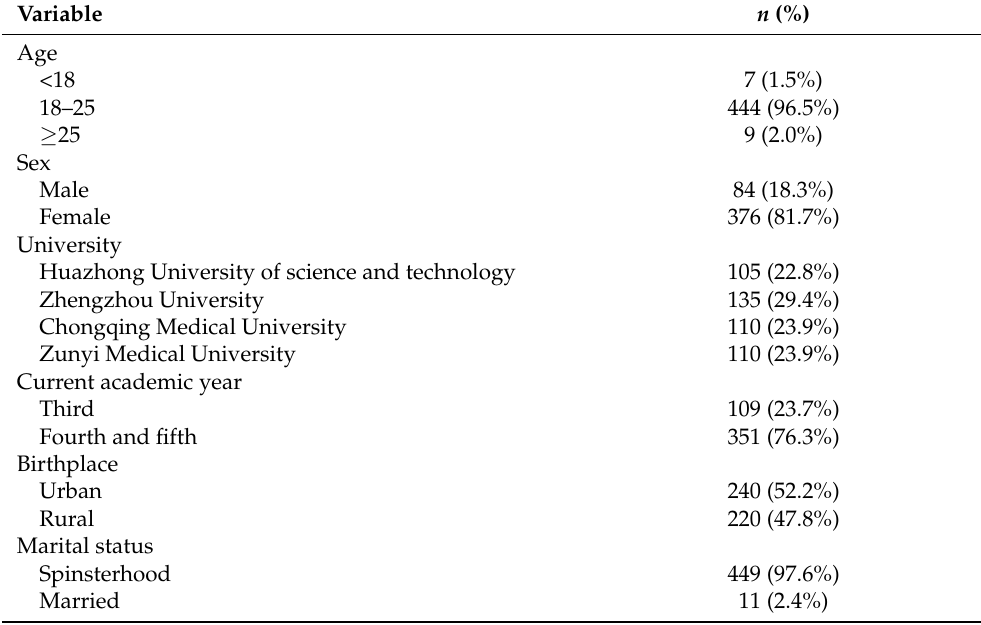
Table 1. Characteristics of Participants ( n =